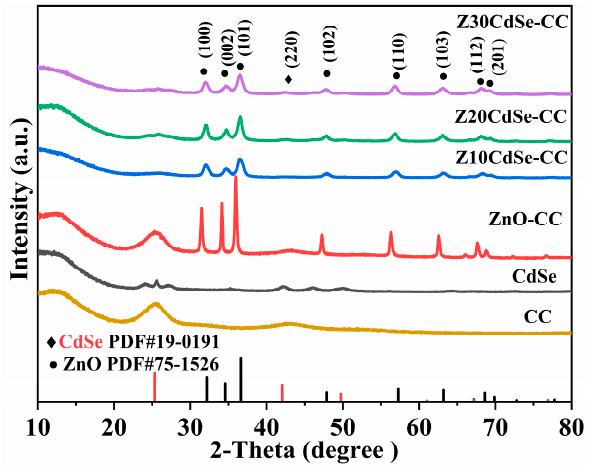
Figure 1. XRD patterns of CC, CdSe, ZnO–CC, Z10CdSe–CC, Z20CdSe–CC, and Z30CdSe–CC. According to the XRD results, the grain sizes of the (100), (002), and (101) crystal